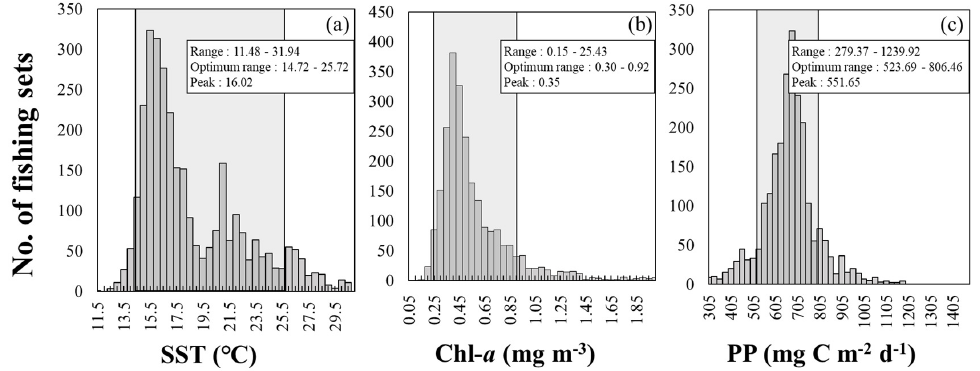
Figure 4. Frequency distributions of ( a ) Sea surface temperature (SST; ◦ C), ( b ) Chlorophyll- a (Chl- a ; mg m − 3 ), and ( c ) Primary production (PP; mg C m − 2 d − 1 ) on the fishing locations for the chub mackerel. Gray squares represent the optimum ranges for each parameter.